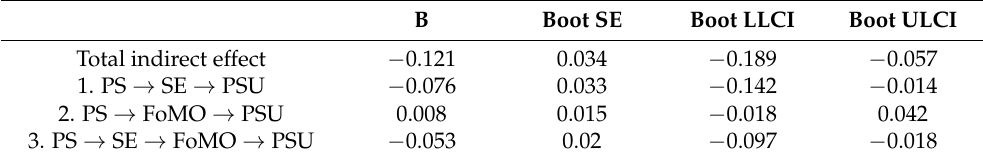
Table 4. Bootstrapping analysis of the mediating